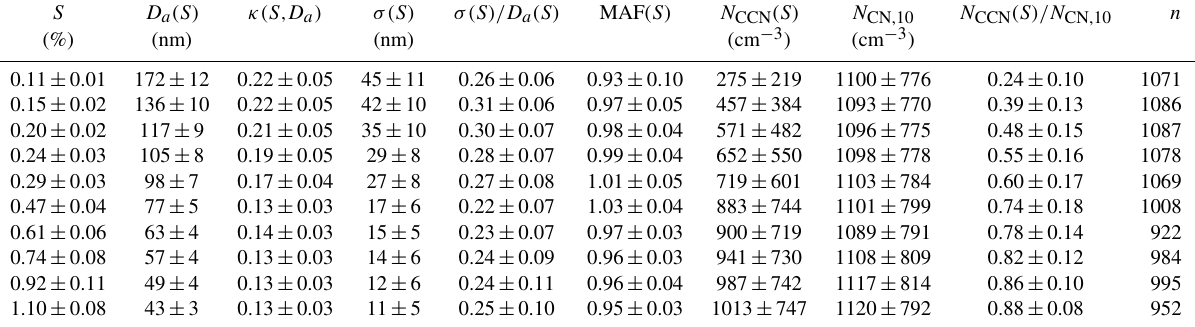
Table 1. Characteristic CCN parameters as a function of the supersaturation S , averaged over the entire measurement period: midpoint activation diameter D a ( S ), hygroscopicity parameter κ ( S , D a ) , width of CCN activation curve σ ( S ), heterogeneity parameter σ ( S)/D a ( S